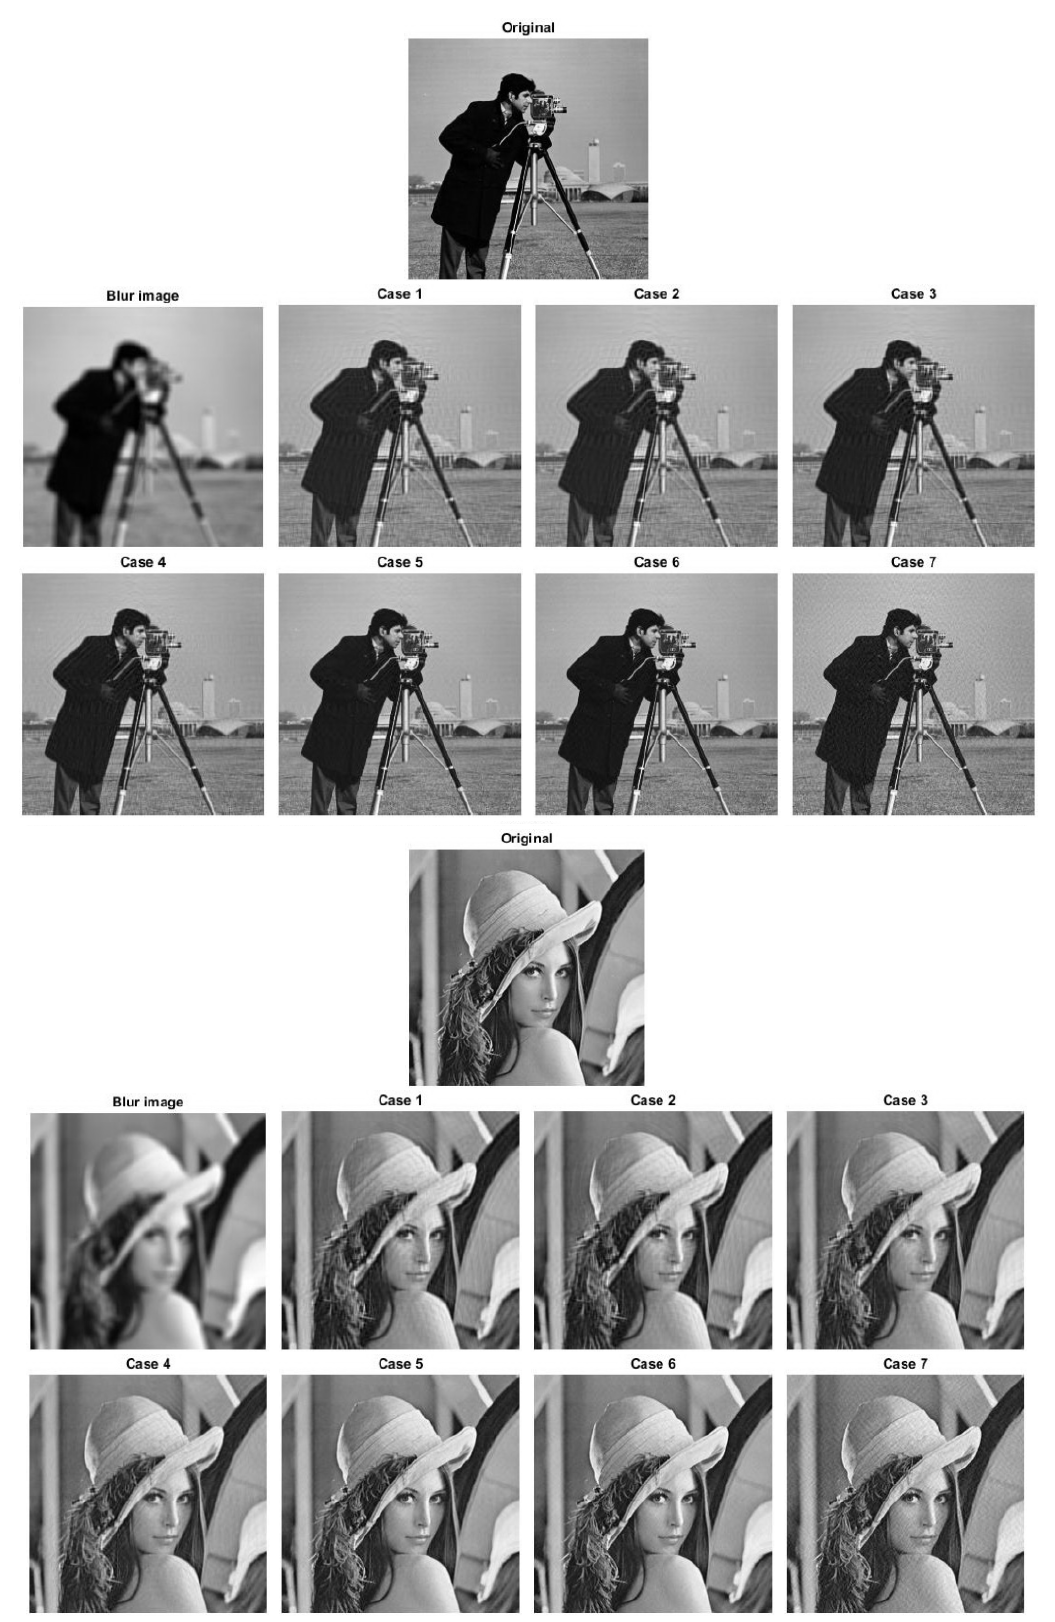
Figure 4. Results of FBMWA for deblurring of the Cameraman and